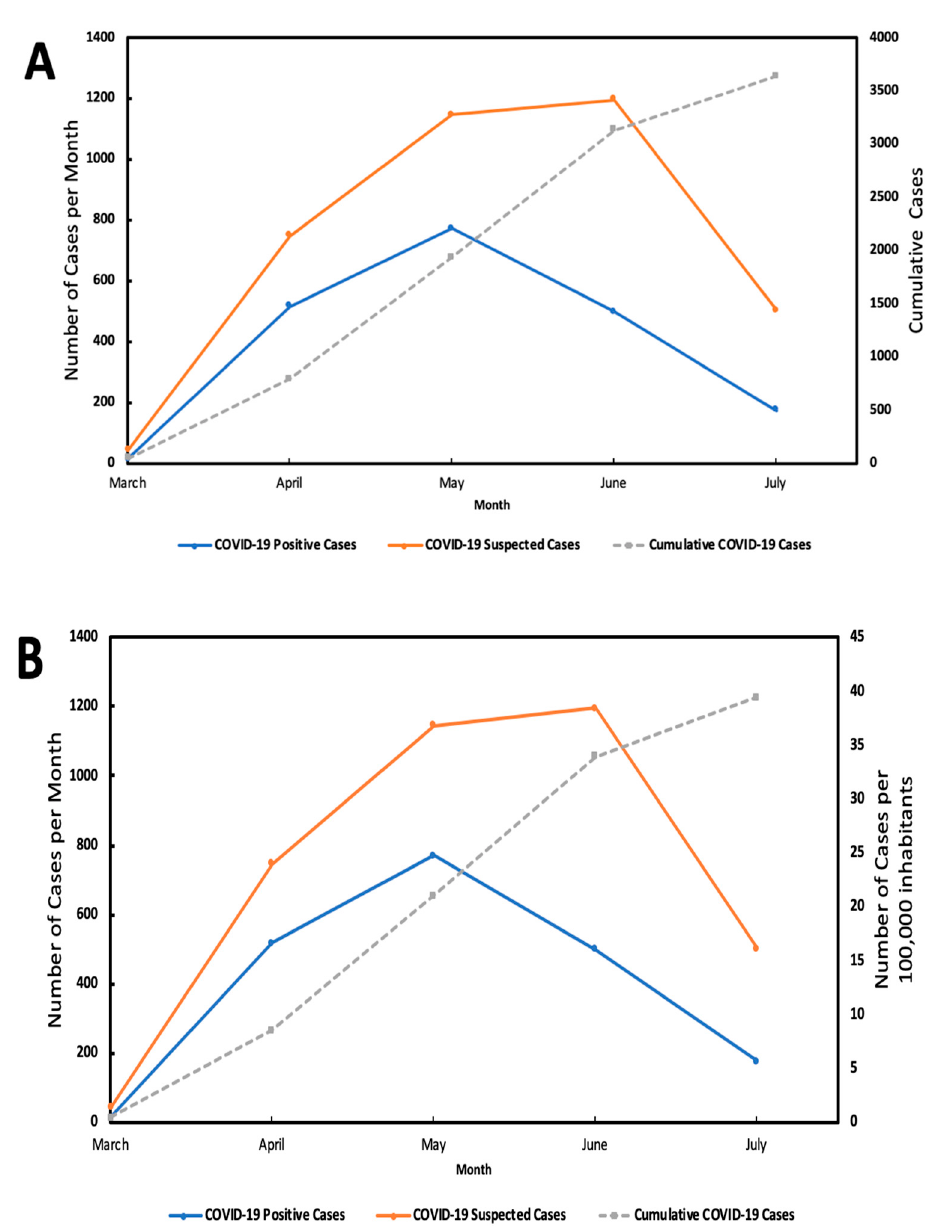
Figure 3. Exponential growth and cumulative cases related to positive (RT-PCR test) and suspected COVID-19 cases: ( A ) represents total cases included from Mexico City and ( B ) represents the num- ber of cases per 100,000 inhabitants, between March–July 2020.